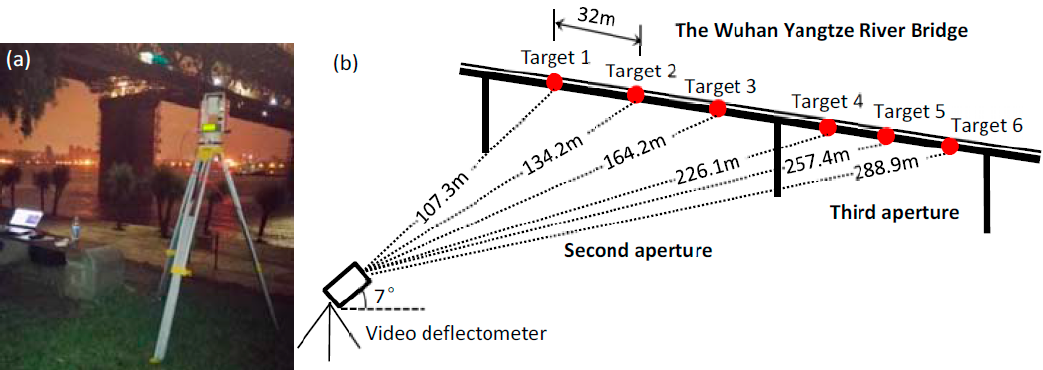
Figure 6. ( a ) The video deflectmeter placed at the riverside; and ( b ) the distances and orentation of the video deflectometer relative to the six measuring points.